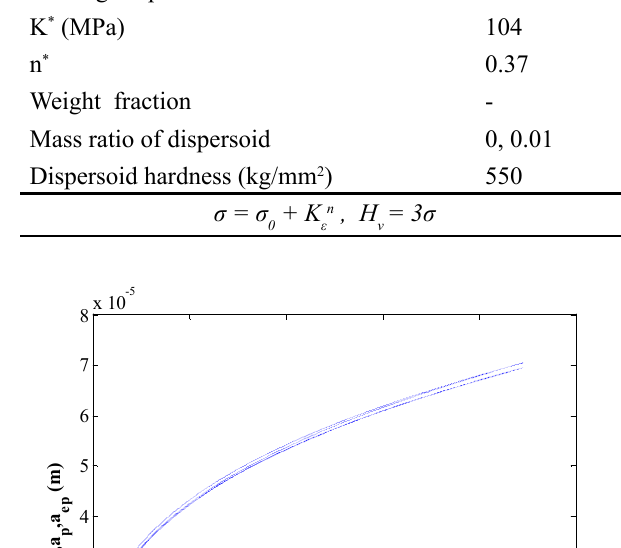
Fig. 5. Normal displacement versus elastic-plastic radius of